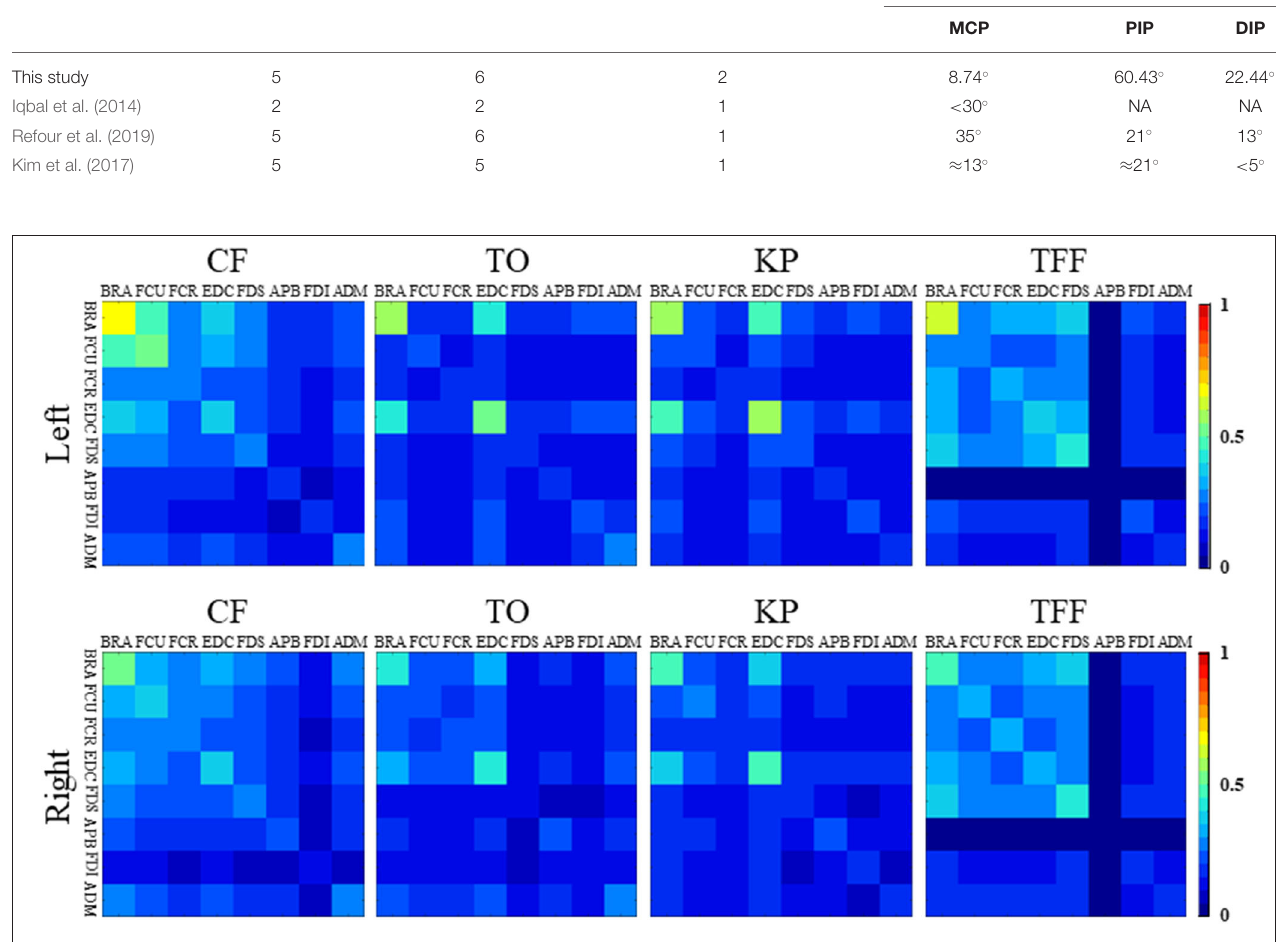
classification accuracies for the H2, H3, and H5 subjects were about 80%, but the accuracy for the H1 subject was lower than 50%. Figure 9 shows the classification accuracies of the seven hand gestures for the five subjects. In general, the classification accuracies for H3, H4, and H5 were better than the other